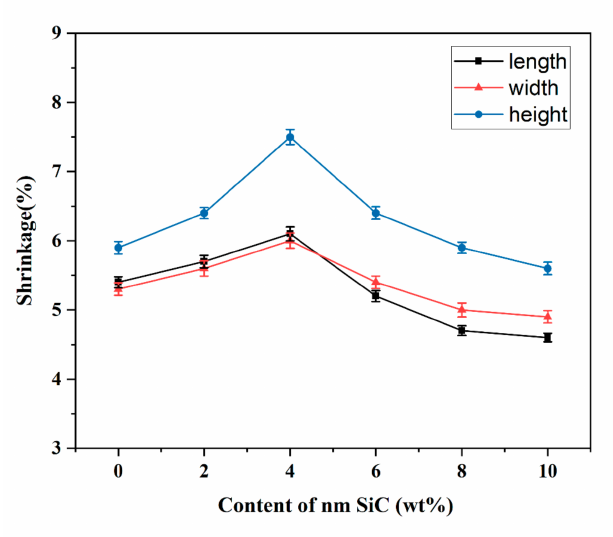
Figure 6. Shrinkage of the sintered samples in the length-width-height